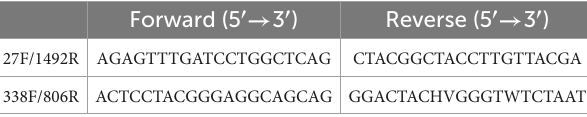
TABLE 1 Sequences of primers for 16S rRNA